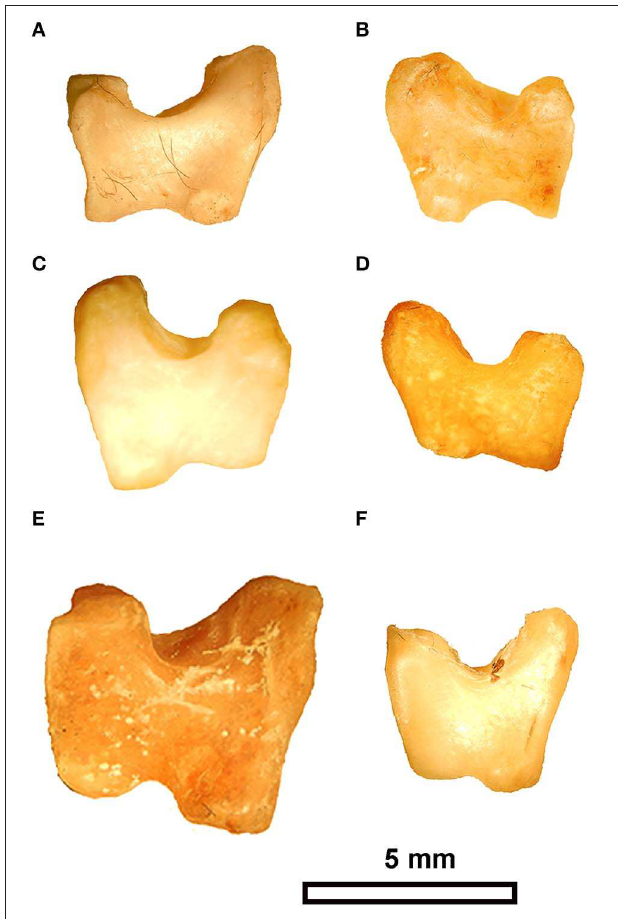
FIGURE 4 | Ulnare morphology in different species of Pteroclidae, (A) Pterocles bicinacitus (USNM 429081), (B) P. burchelli (USNM 430845), (C) P. gutteralis (USNM 488869), (D) P. decoratus (USNM 636741), (E) P. orientalis (USNM 344845), and (F) P. namaqua (USNM 64231). Scale bar equals 5mm. USNM - the bird division of the National Museum of Natural History, Washington, DC,